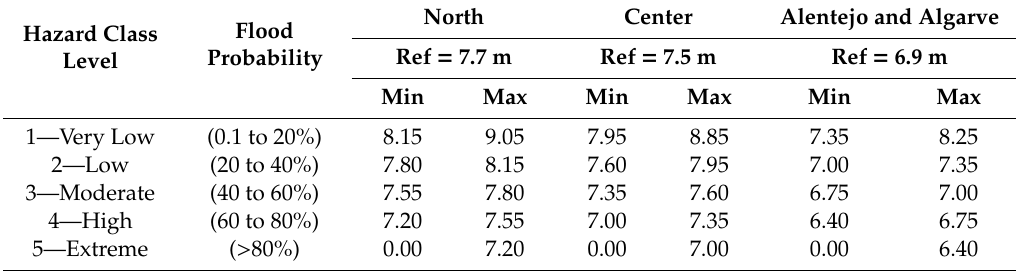
Table 9. Intervals for each EFHI level and respective probability for the SLR 2100 scenario with 100-year RP storm surge and the additional setup component for each geographic zone, relative to the central reference flooding elevation level (the Ref value corresponds to the EFL central estimation).